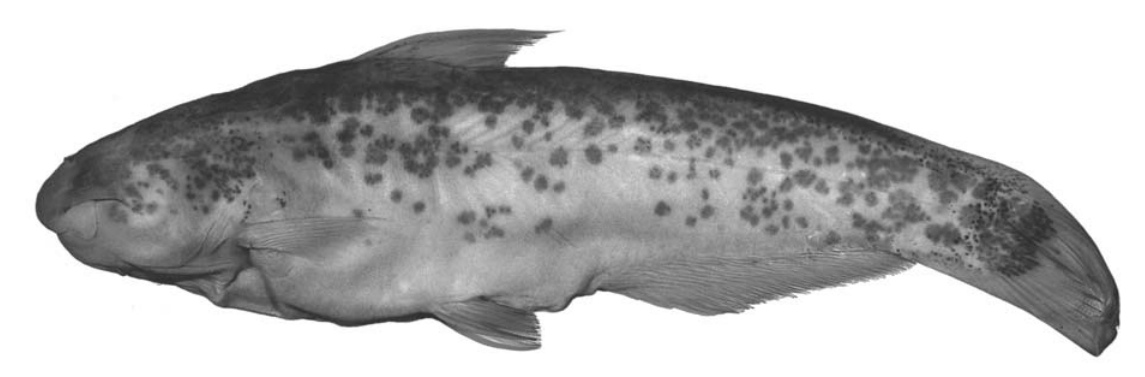
Fig. 26. Cetopsis montana , new species, holotype, LACM 41989-1, 108 mm SL; Peru, Amazonas, 100 m upriver from Caterpiza (latter locality at 3°55’S,